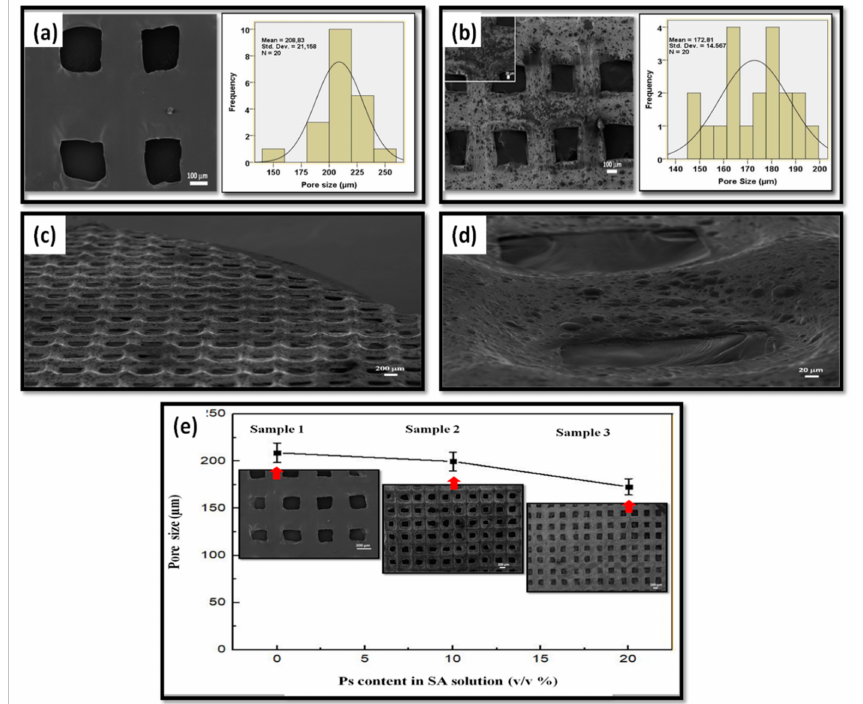
Figure 4. SEM images of 3D-printed SA and Ps-incorporated SA sca ff olds. ( a ) SA sca ff olds and pore size histogram (Sample 1). ( b ) Ps included SA sca ff olds and pore size histogram (Sample 3) ( c ) SEM image of Sample 3 sca ff old from di ff erent angle. ( d ) Magnification of the sca ff old pores. ( e ) Pore size distribution according to propolis